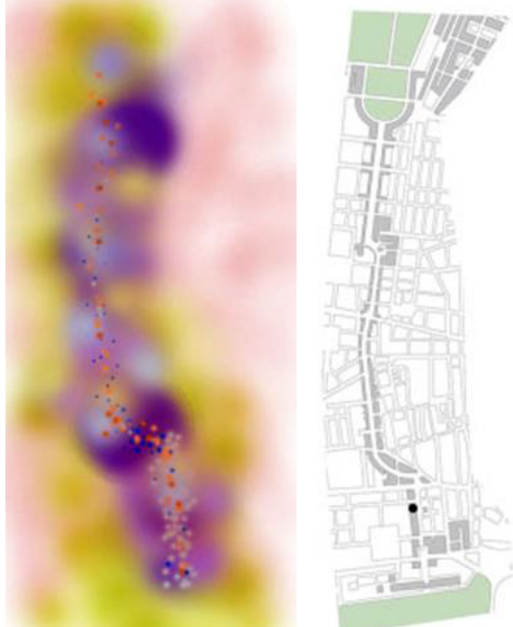
Figure 19: Proposing an original Paint of Modern Life (left) in Regent Street painted by the author. Last but not least, by using data on the network system that is based on spatial triad, I would like to propose an original illustration of Regent Street (1818-48) that is inspired from the “Painter of Modern Life” where each colour stands (used the colours in-network; yellowish-orangeish/ladies/shops, blues/gentlemen/machinery, greyish/practicality/hygiene, purplish/neoclassicism/eclectism) for an agency (the same colour coded in the network) to represent the layers of modern societies. All those colours stand for themselves and interact or create new colours and a blurred harmony rather than a